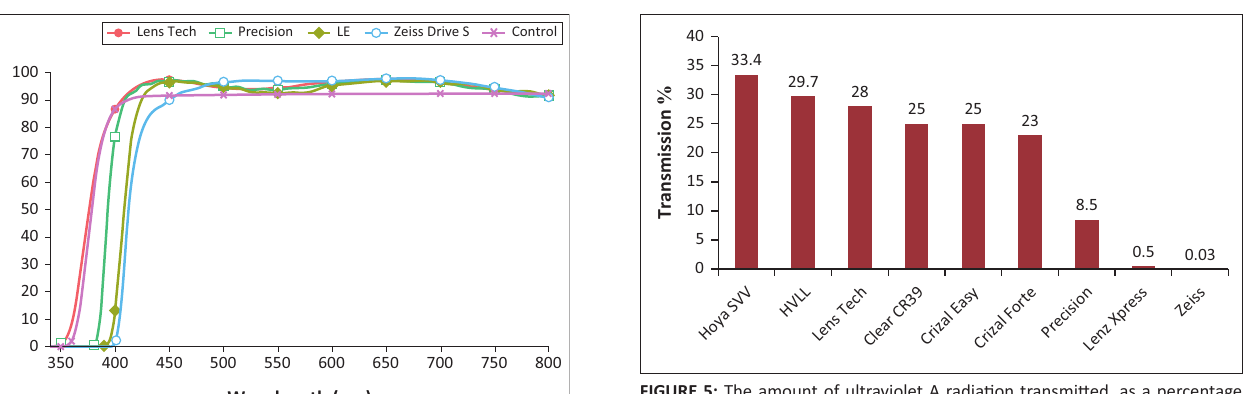
FIGURE 5: The amount of ultraviolet A radiation transmitted, as a percentage (between 320 nm and 400 nm), through each lens. The percentage is shown at the top of each